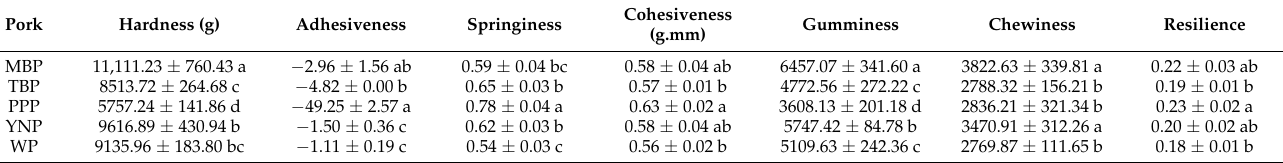
amino acid score; EAAI, essential amino acid index; PER, protein efficiency ratio [30]. Table 5. Texture profiles of the five types of